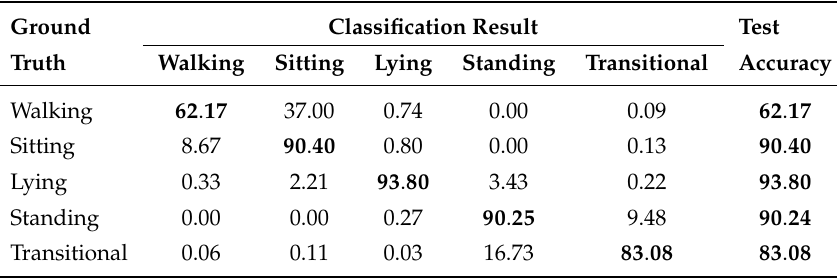
Table 3. Mean accuracy of the first-layer random forest (%).